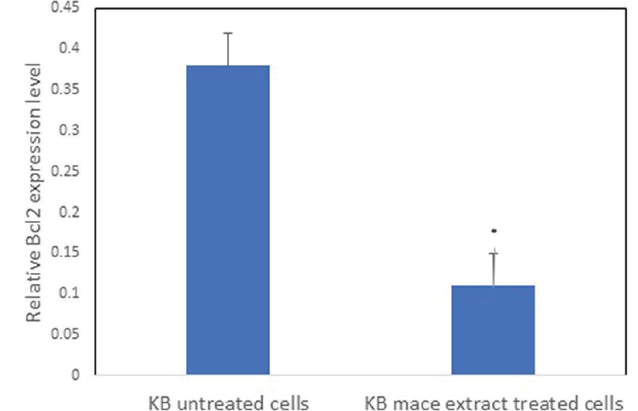
FIGURE 7 - The m-RNA expression levels were analyzed by densitometry, and the data is presented as mean intensity in relative arbitrary densitometric units (ADU) ± SEM with n = 3. * P < 0.01 are statistically significant compared to KB untreated